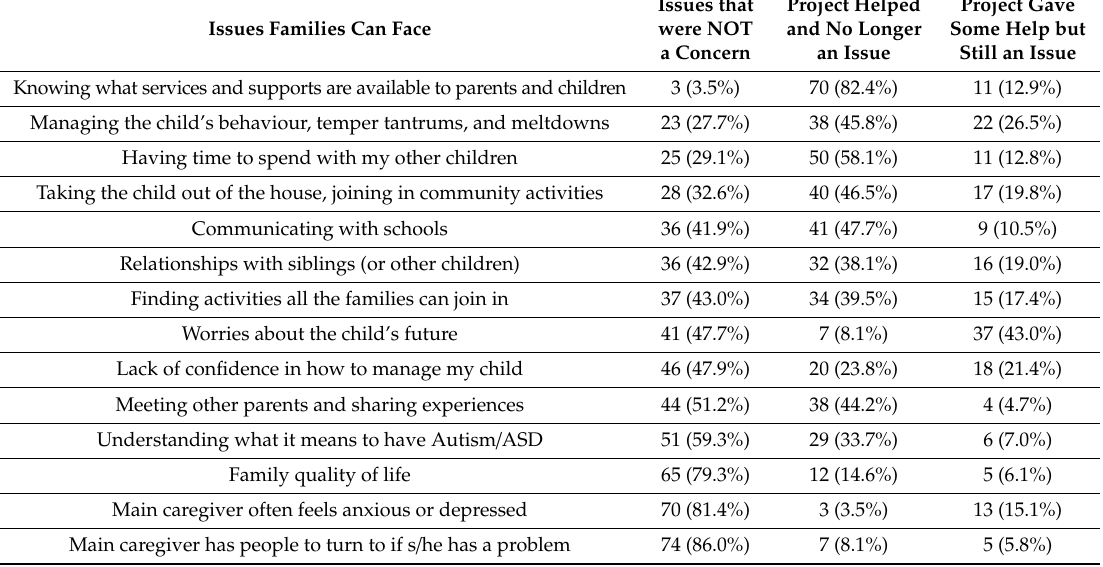
Table 2. The number and percentage of families rated by sta ff on outcomes